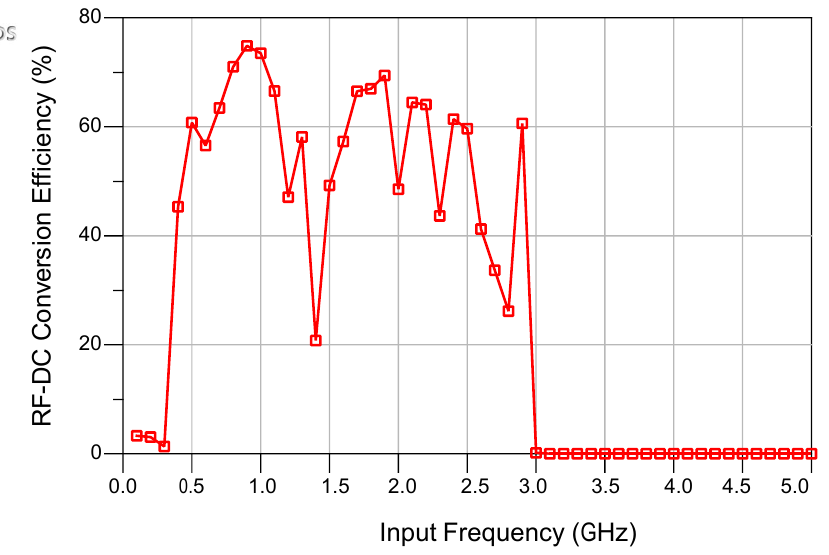
Figure 13. RF-DC conversion efficiency vs. the input frequency of the proposed quad-band circuit with a single receiving antenna for the load of 5 k Ω .